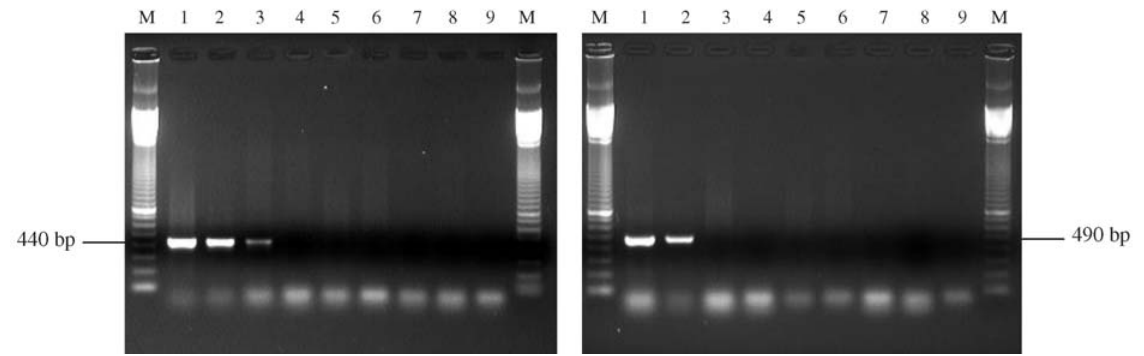
Figure 4 - Amplification of DNA from pure cultures and infected larvae using the primer sets ITSMet/ITS4 (A) and ITS14/ITS4 (B). Primer set A: 1 = strain E 9 ; 2 = larvae infected by strain E 9 ; 3 = strain 14; 4 = larvae infected by strain 14; 5 = strain 201; 6 = strain 204; 7 = strain 959; 8 = non-infected lar - vae; 9 =control reaction without DNA. Primer set B: 1 = strain 14; 2 = larvae infected by strain 14; 3 = strain E 9 ; 4 = larvae infected by strain E 9 ; 5 = strain 201; 6 = strain 204; 7 = strain 959; 8 = non-infected larvae; 9 = control reaction without DNA. M = 100 bp DNA marker.